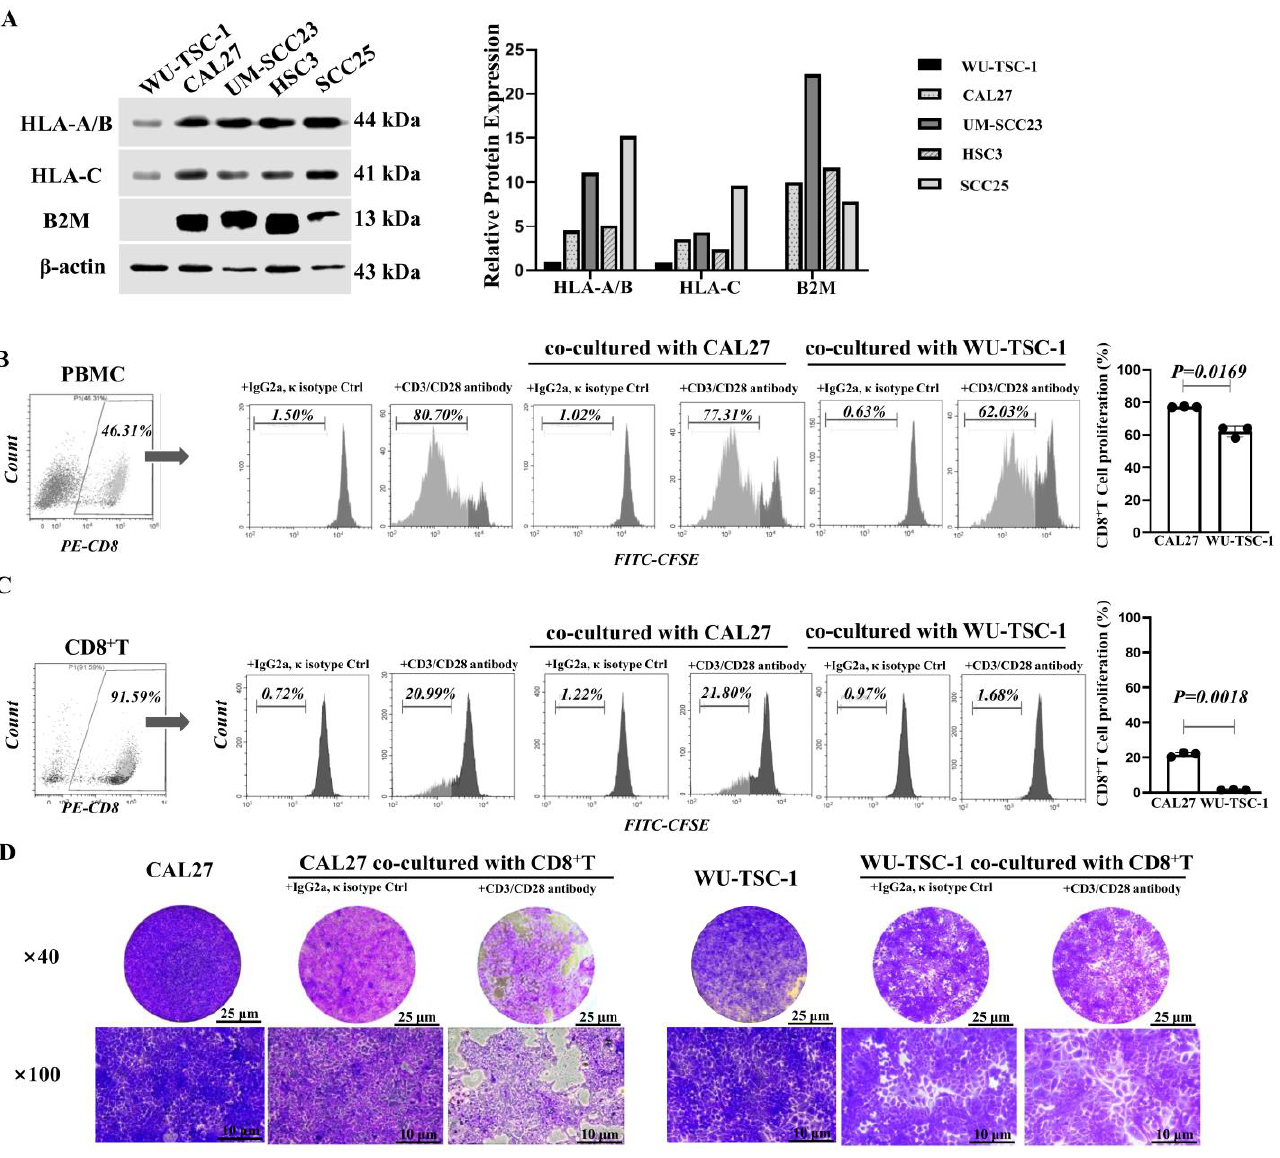
Figure 6. Functional assay of WU-TSC-1: ( A ) Expression of HLA-A/B, HLA- C and β2M in HNSCC cell lines. ( B , C ) Cell proliferation of CD8 + T cells co-cultured with WU-TSC-1 or CAL27. CD8 + T cells were sorted from PBMC after co-culture ( B ) and isolated CD8 + T ( C ). Each dots represents an individual test. ( D ) Cytotoxic effect of CD8 + T on WU-TSC-1 or CAL27. Crystal violet staining, 40× and 100×.